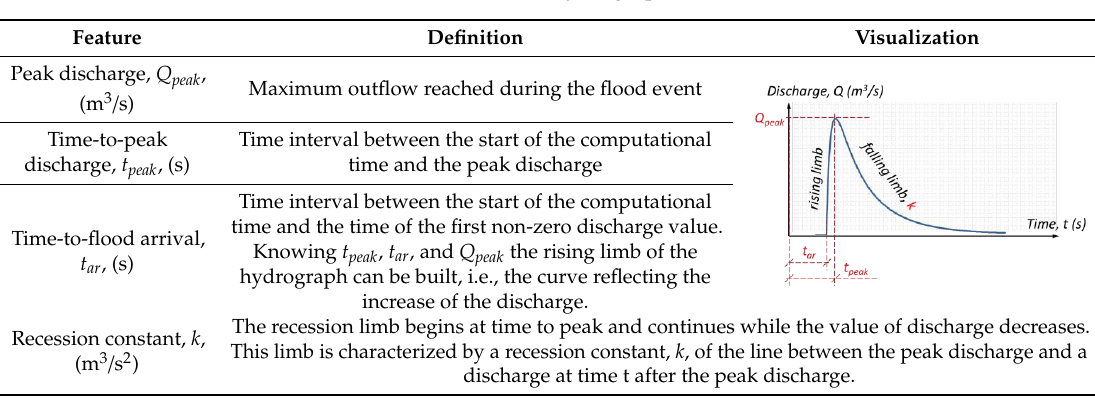
Table 3. Definition of hydrograph features.